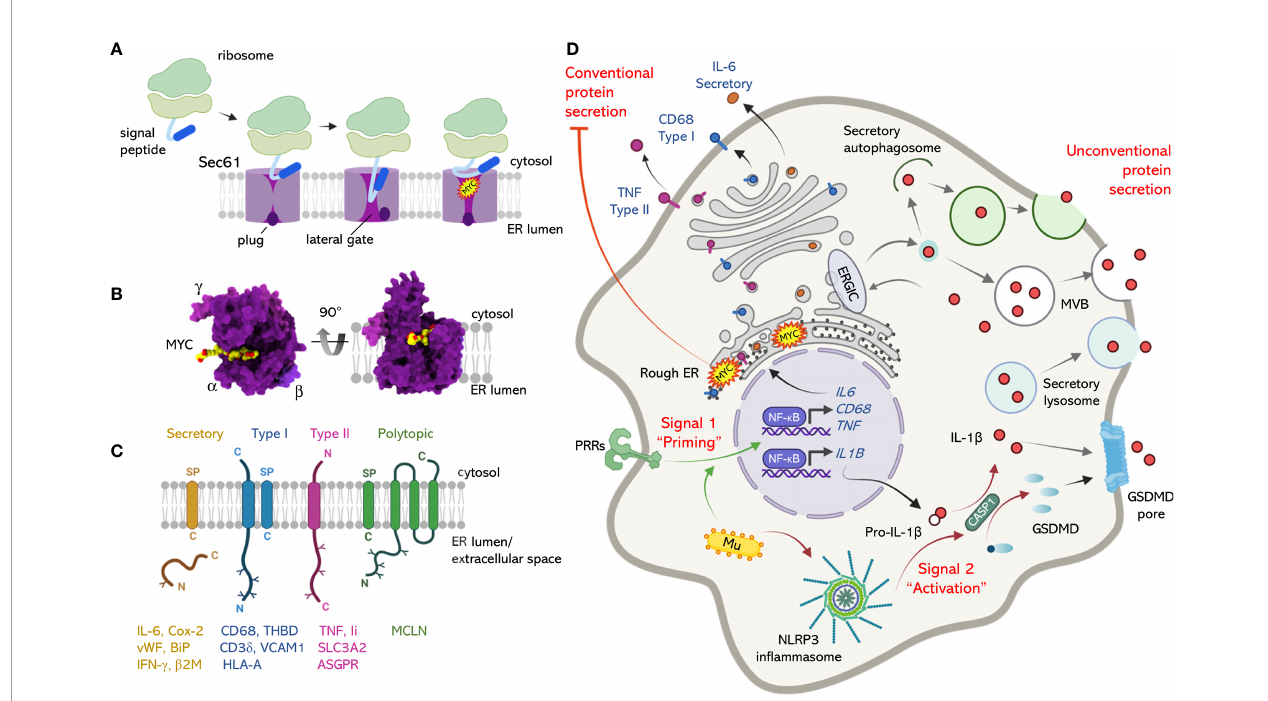
FIGURE 1 | The mechanism of action of mycolactone at the Sec61 translocon and its in fl uence over conventional and unconventional secretion. (A) Sec61-dependent co- translational translocation of proteins into the ER involves recognition of a signal peptide (SP) or signal anchor by the signal recognition particle and its receptor (not shown), which transfer it to Sec61. This results in reorganization of the translocon and movement the Sec61 a plug domain, opening the central pore and allowing transit of the translating protein into the ER. Mycolactone binds Sec61 a , preventing the SP from accessing its binding site at the lateral gate. Although the lateral gate is open, the plug remains closed and the translocon is locked in an inactive state. (B) The structure of inhibited Sec61, with mycolactone bound inside the lateral gate of Sec61 a . Dark purple; Sec61 a , light purple; Sec61 b , pink; Sec61 g , yellow/red = mycolactone (from PDB:6Z3T). Two views are shown, looking down from the cytosol towards the ER and from the side, as in (A) . (C) Mycolactone-dependent inhibition of Sec61 affects a wide range of proteins, including secretory proteins with SP, type I transmembrane proteins (N-terminal ‘ out ’ , with SP), type II transmembrane proteins (N-terminal ‘ in ’ , with signal anchor), and a subset of polytopic proteins (particularly those with an SP). (D) Conventional and unconventional secretion of cytokines and in fl ammatory mediators. Stimulation of macrophage pattern recognition receptors (PRRs) promotes activation of signalling pathways (Signal 1) e.g., NF- k B, leading to transcriptional induction of many genes, including conventionally secreted proteins (eg IL-6), type I transmembrane proteins (eg CD68), type II transmembrane proteins (eg TNF, cleaved from the cell surface by ADAM17, not shown), as well as unconventionally secreted proteins (eg IL-1 b ). Here, the pathways diverge, with conventionally exported in fl ammatory mediators entering the ER via Sec61 while pro-IL-1 b translation occurs in the cytosol. Activation of the NLRP3 in fl ammasome (Signal 2) activates pro-caspase 1, which cleaves pro-IL-1 b to its mature form. Mature IL-1 b is secreted via unconventional secretion pathways involving gasdermin D (GSDMD) pore formation, and/or membrane-bound organelles such as multivesicular bodies (MVB), autophagosomes and secretory vesicles loaded via TMED10 (not shown) at the ER-Golgi intermediate compartment (ERGIC). M. ulcerans (Mu) was recently shown to provide Signal 1 by means of TLR2 activators on its cells surface, and Signal 2 via mycolactone (MYC), which also inhibits Sec61 at the ER membrane. Figures generated using BioRender.com and Chimera X